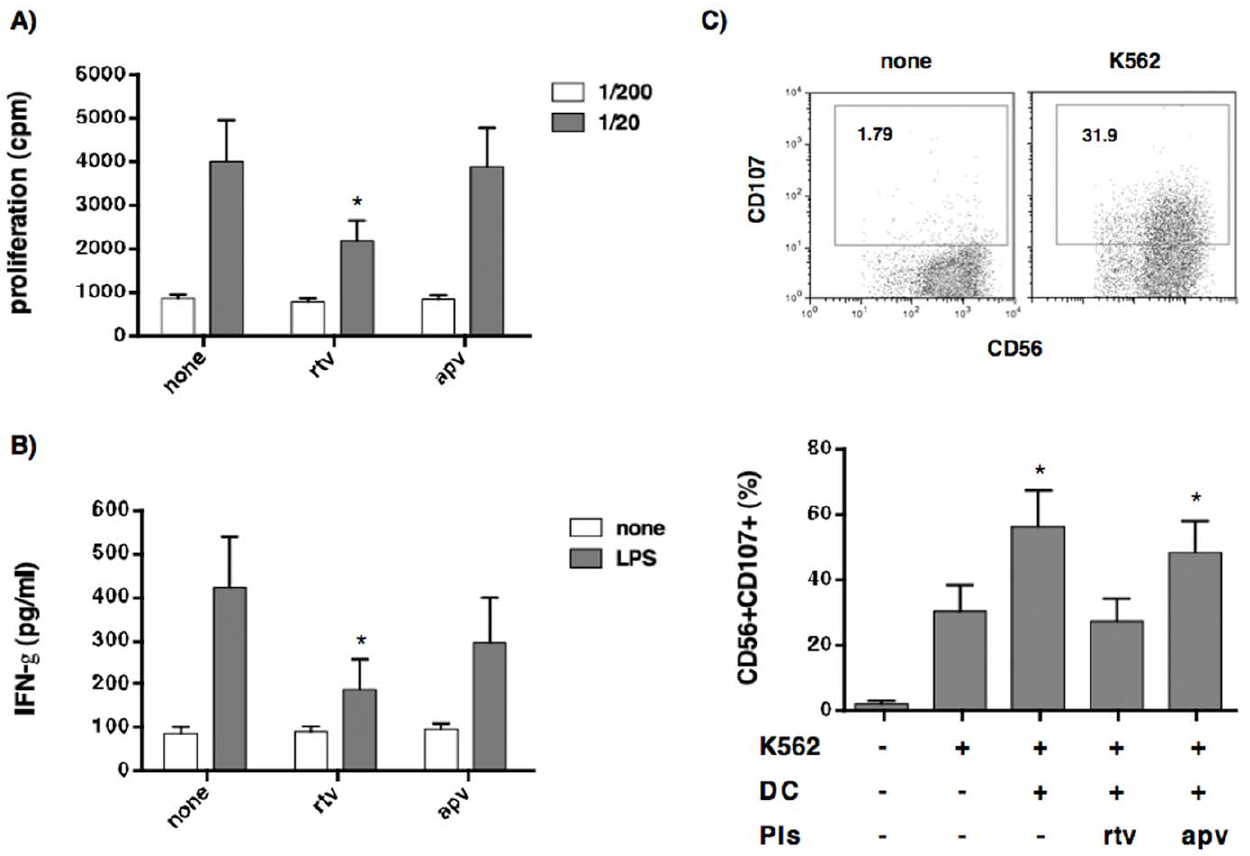
Figure 4. DCs generated in the presence of ritonavir fail to activate autologous NK cells. iDCs generated in regular medium (none) or in the presence of PIs (rtv or apv) were exposed to LPS (100 ng/ml). After 24 hours, cells were collected, washed and co-incubated with autologous NK. (A) Proliferative response of NK cells co-cultured for 4-days with autologous DCs in serial dilutions. Mean and SD are calculated on 5 independent experiments. (B) Accumulation of IFN- c in supernatants derived from 24-hours NK/mDC co-cultures. Mean and SD are calculated on 5 independent experiments. (C) NK cells were co-cultured with autologous mDC for 24 hours, before being tested for their ability to de-granulate in response to K562 cell line. Upper panels: representative dot plots showing CD107 expression in CD56 + NK cells cultured with or without K562 (left and right panel, respectively). Lower panel: bars graph report the percentage of CD56 + /CD107 + NK cells primed with autologous DCs generated in the presence of rtv, apv or regular differentiation medium for 24 hours, and co-cultured with K562 for 4 hours. Results shown are representative of five independent experiments. (* p , 0.005).